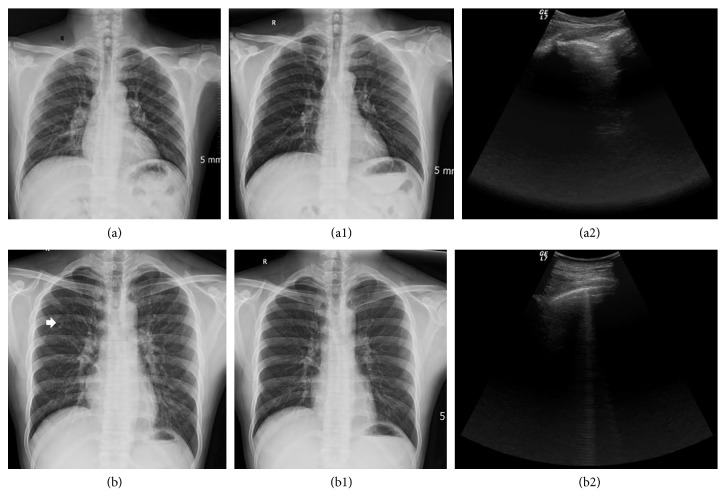
Examples of HAPE patients with negative manifestation of LUS. (a) CXR before treatment: enlarged hilar shadows can be observed; (a1) corresponding CXR after treatment: the image returned to normal; (a2) corresponding LUS before treatment: the images were normal, and no B-lines were detected; (b) CXR before treatment: densified hilar shadows and small patch shadows can be observed in the upper left lung (white arrow); (b1) corresponding CXR after treatment: the image returned to normal; (b2) corresponding LUS before treatment: only a few B-lines (B-line score = 2) were detected.